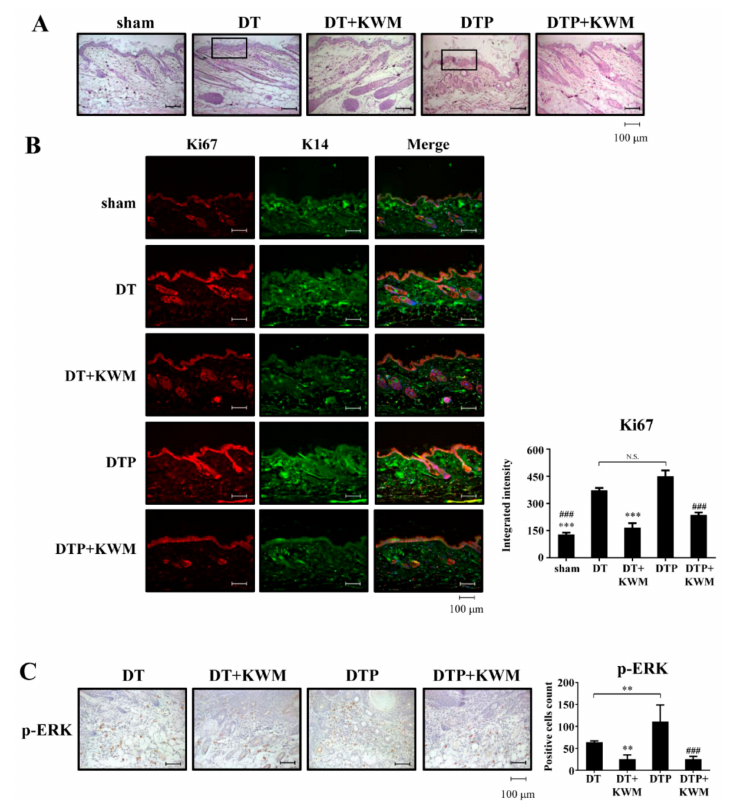
Figure 4. E ff ect of KWM-EO on skin and papilloma tissue from mice. ( A ) Skin morphology was examined by H&E staining. ( B ) Abnormal epidermal proliferation was detected by immunofluorescent staining of ki67 (red). Basal keratinocytes were stained with K14 (green), and nuclei were stained with DAPI (blue). ( C ) Histological images of papilloma indicated the paradoxical activation of p-ERK. Representative images are shown. The data are representative of three independent experiments and are expressed as mean ± SD. N.S. means non significance; P ** < 0.01, P *** < 0.001 compared to DT group; P ### < 0.001 compared to DTP group (ANOVA). Scale bar: 100 µ